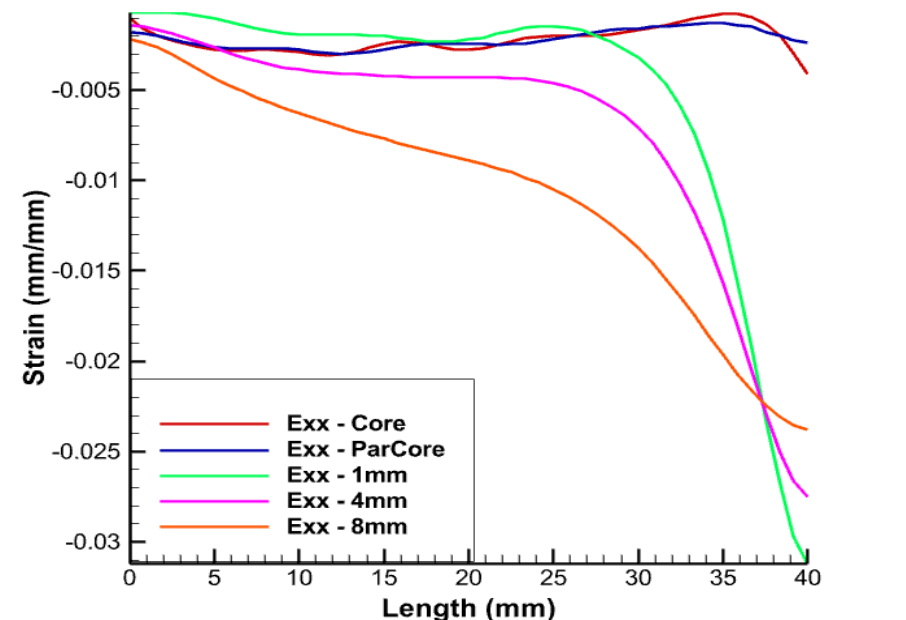
Figure 10. E xx strain for pure tension test case.